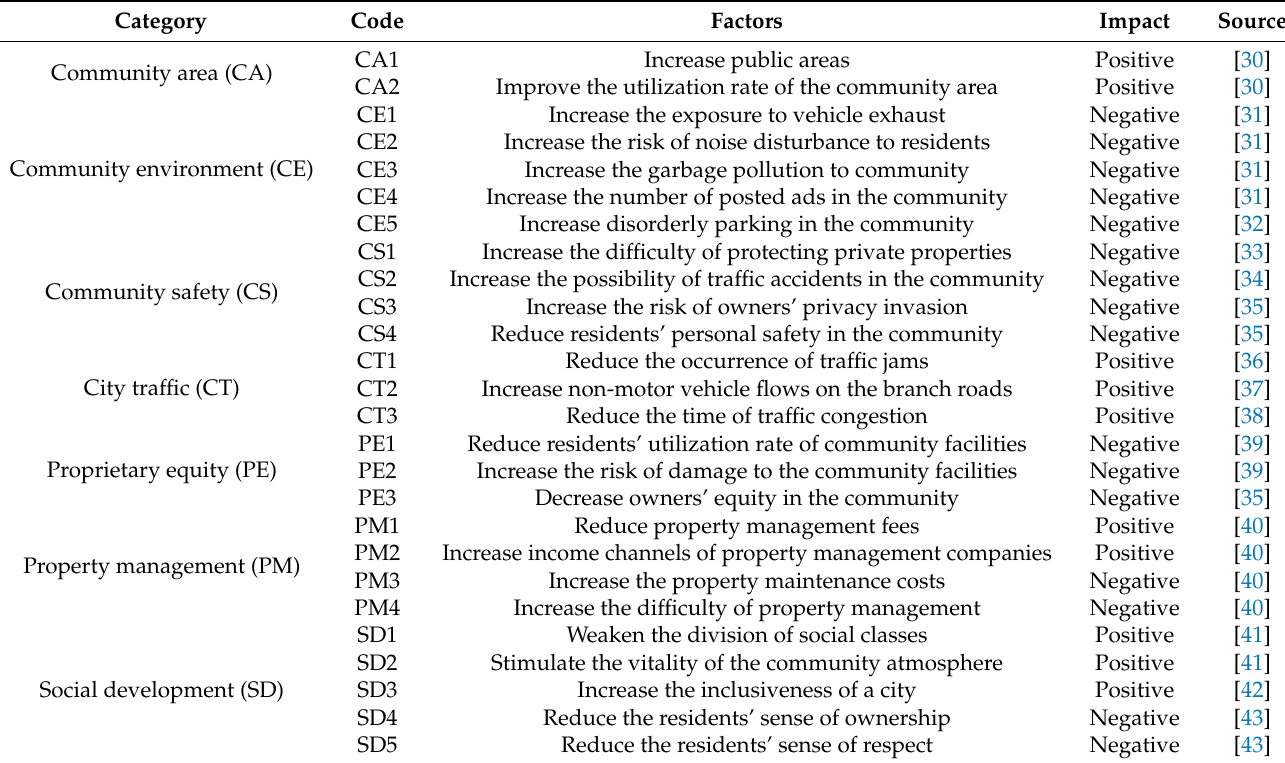
Table 1. Factors affecting the opening of gated